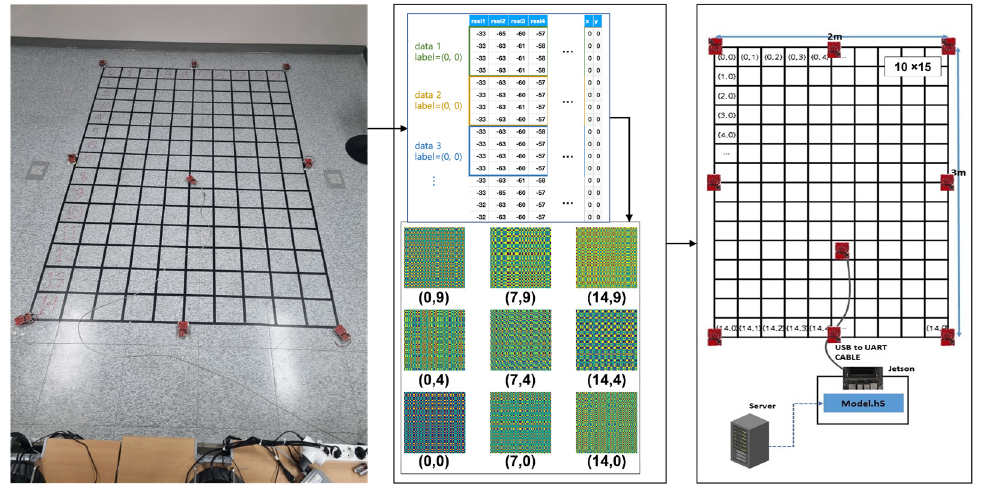
Figure 8. Environment of testbed for the experiment of indoor location recognition using the pro- Environment of testbed for the experiment of indoor location recognition posed approach. using the proposed approach.